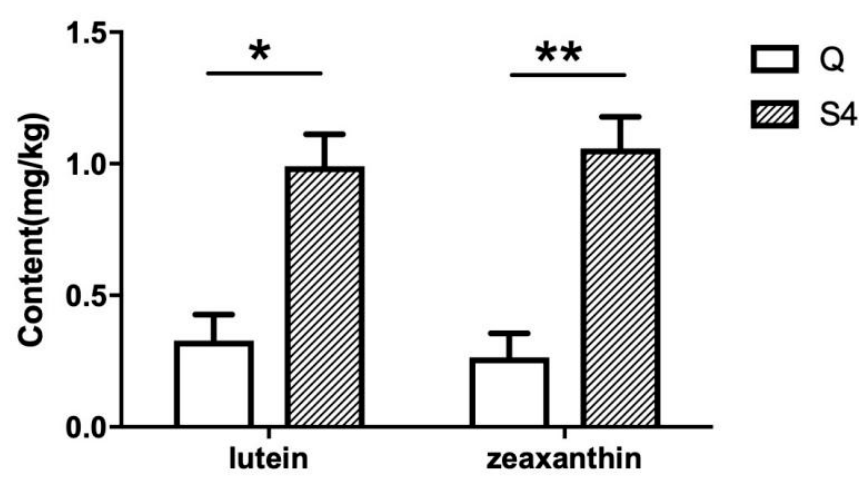
Figure 1. Concentrations of lutein and zeaxanthin in skin from chickens differing in their skin color by the HPLC. Data are expressed with means ± SE ( n = 3). Q represents the Qing jiao ma as white-skin chicken, and S4 represents the Guangxi Huang as yellow-skin chicken; * and ** indicate significant differences between different breeds (* p ≤ 0.05; ** p ≤ 0.01).